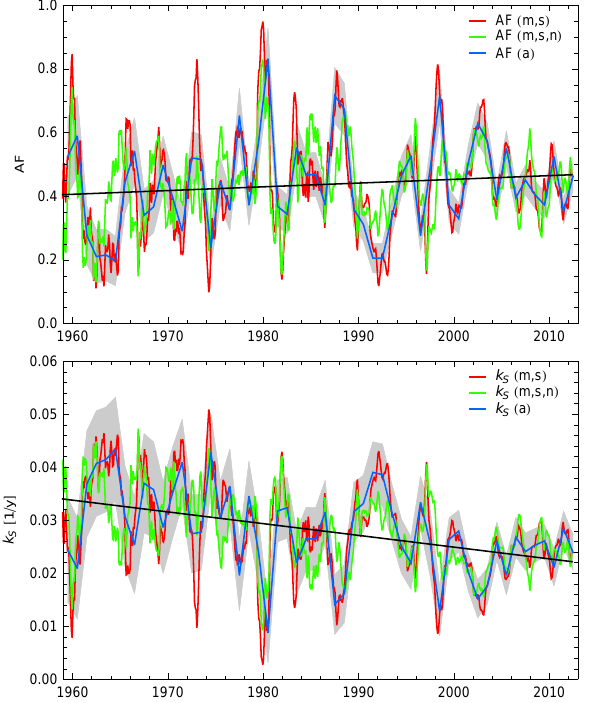
Figure 1. Upper panel: (red) monthly airborne fraction AF( m , s ) with 15-month running-mean smoothing, (green) AF( m , s , n ) with removal of noise correlated with El Niño–Southern Oscillation (ENSO), (blue) annual AF( a ), and (black) best-estimate trend line from AF( m , s , n ) with the combined method. Lower panel: (red) monthly CO 2 sink rate k S ( m , s ) with 15-month running-mean smoothing, (green) monthly k S ( m , s , n ) with ENSO-correlated noise removal, (blue) annual k S ( a ), and (black) best-estimate trend line from k S ( m , s , n ) with the combined method. Grey bands indi- cate ± 1 σ ranges due to observation uncertainties in emissions and CO 2 concentrations, referenced to annual ( a ) series.